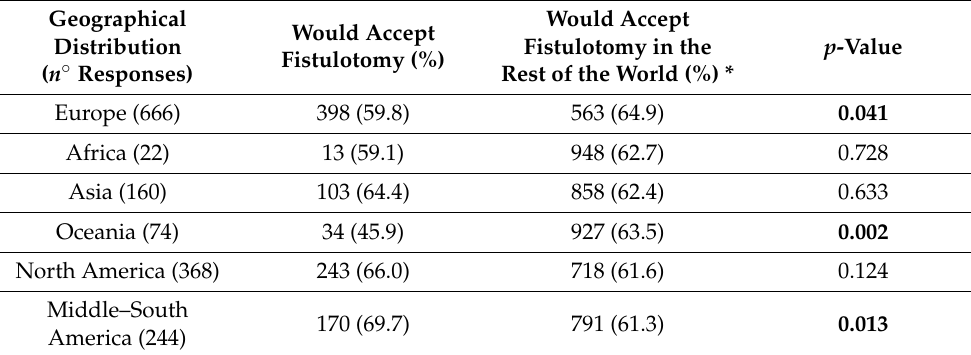
Table 4. Geographical distribution of 767 surgeons who would accept fistulotomy, compared to surgeons who would do that in the rest of the world considering the double response of each single surgeon for low and high fistula together (chi-squared test). The p -value in bold was statistically